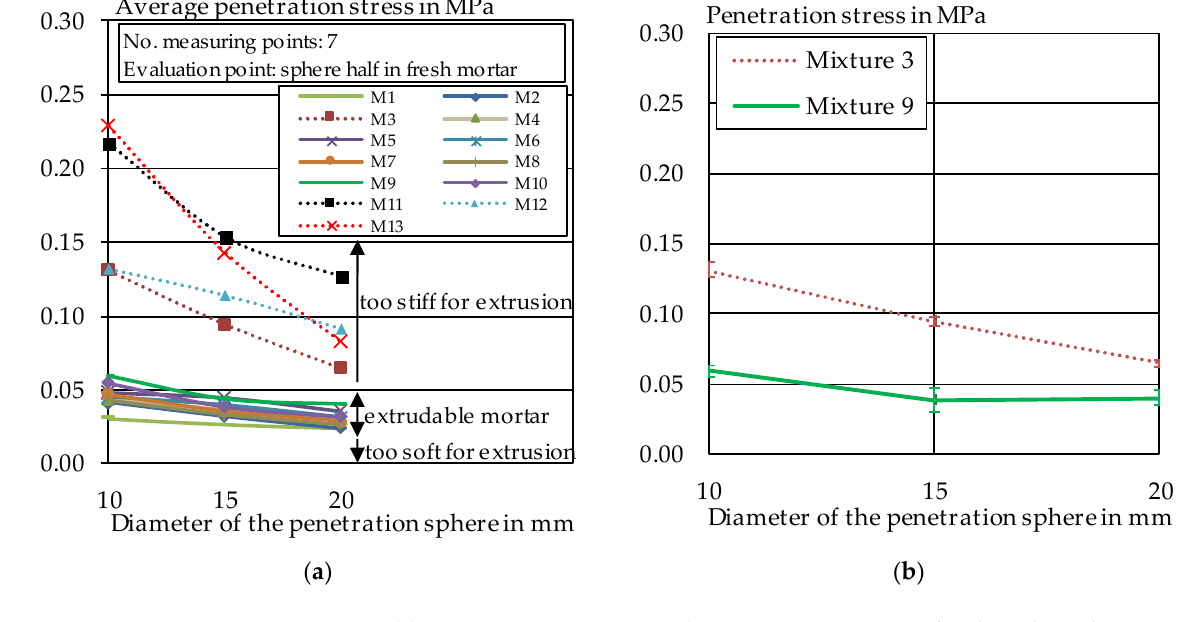
Figure 14. ( a ) Mean penetration stress during penetration tests for the sphere diameters 10 mm, 15 mm and 20 mm for all compounds. Non-extrudable compounds are shown as dotted lines. ( b ) Results of the penetration tests including scattering of seven individual results for mixture 3 and mixture 9.